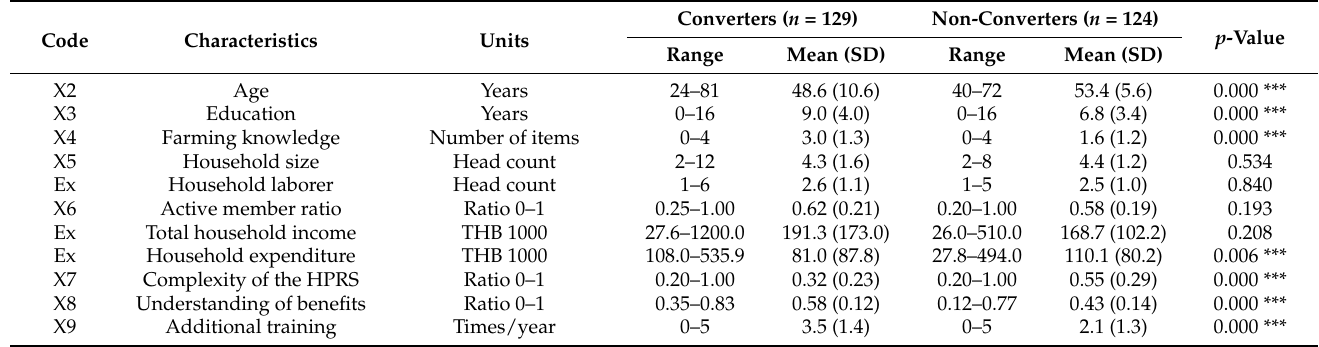
Table 6. Descriptive statistics for respondents’ characteristics: Numerical